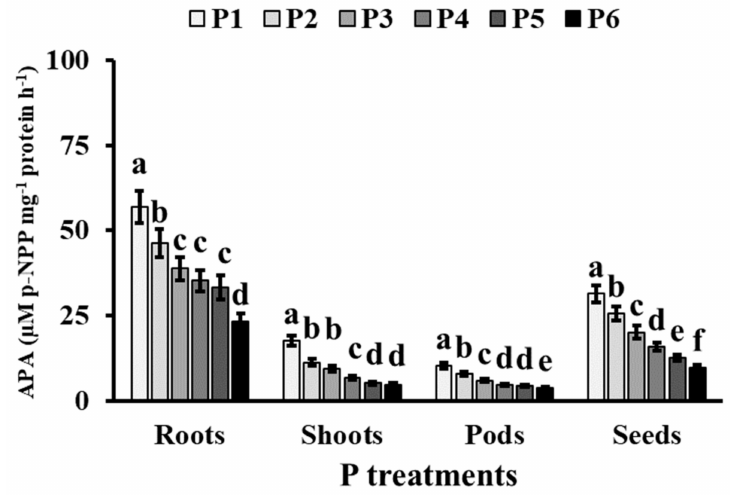
Figure 3. Effects of different P treatments on acid phosphatase activity in roots, shoots, pods and seeds of green bean plants at the end of the experiment. Means with the same lower-case letter are not significantly different at p < 0.05 according to LSD and one-way ANOVA. Error bars represent standard deviation of the means (SE), n = 6.